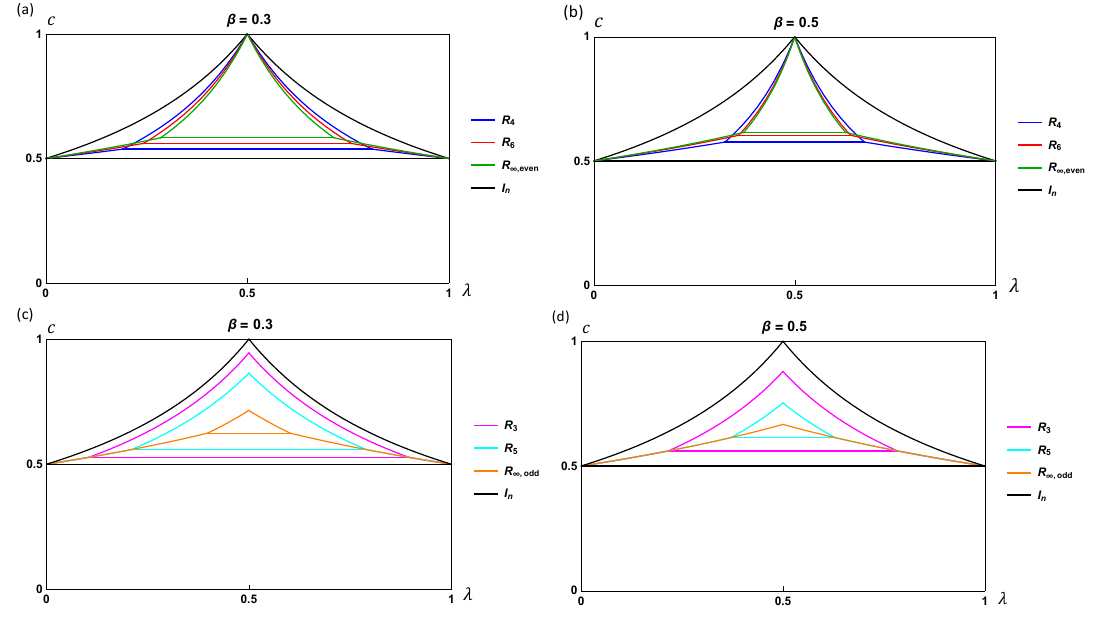
Figure 6 . Transition lines for R n at two different values of β for f ( β ) in